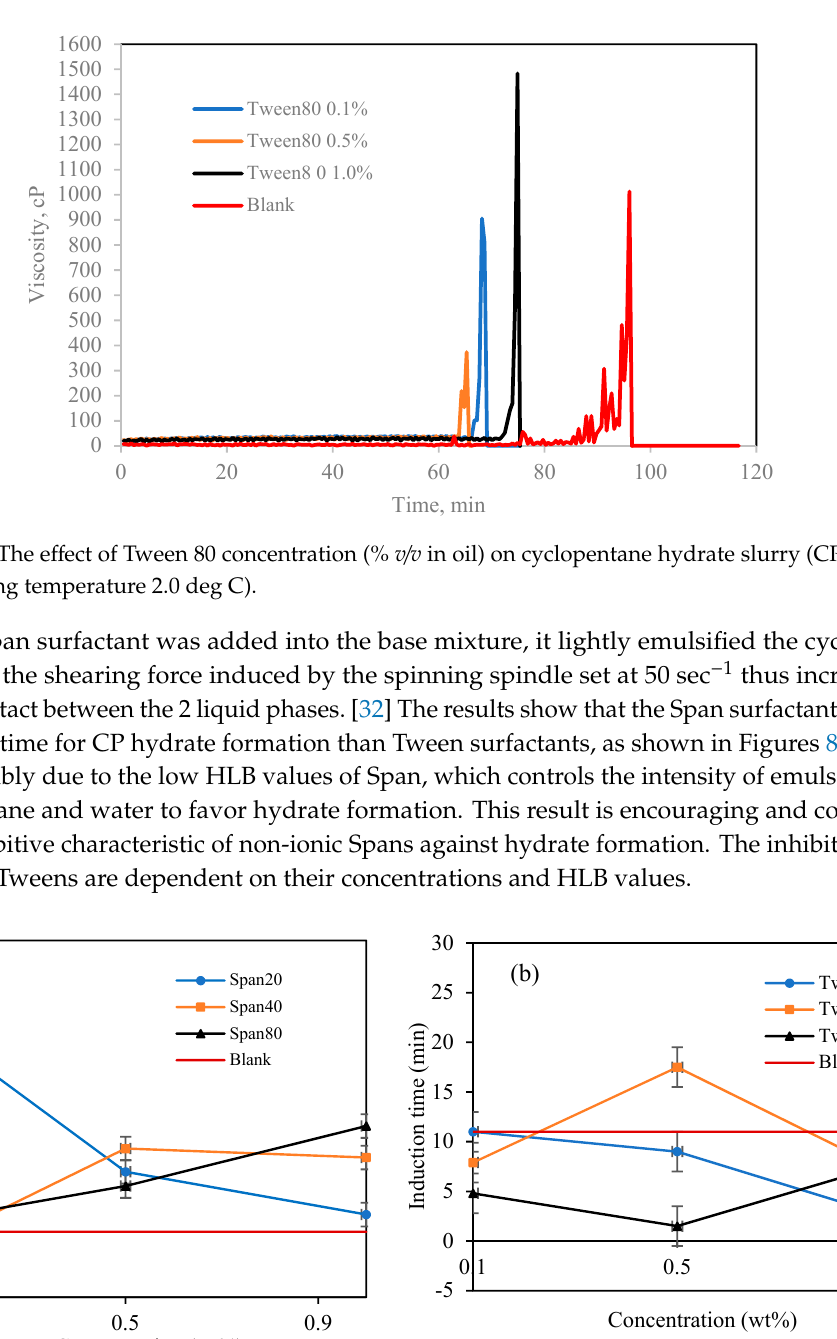
Table 2. Measured hydrate induction time and crystallization time.